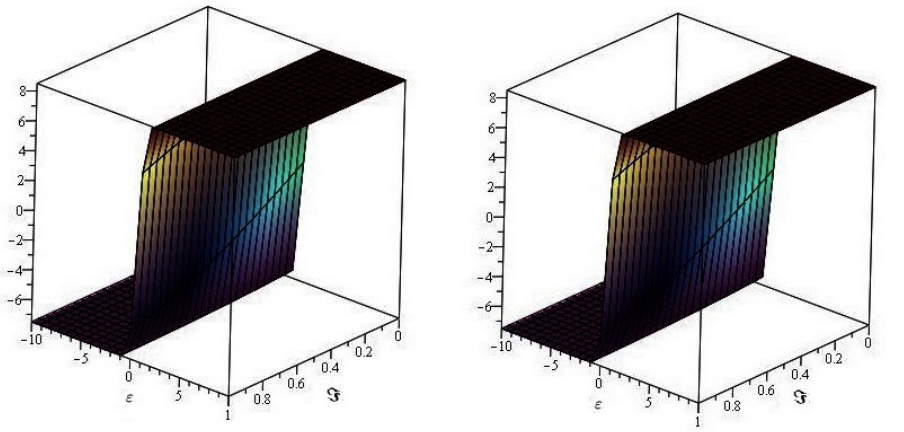
Figure 5. The actual and YDM solution of U ( ε , (cid:61) ) at ℘ = 1 of Example 2.